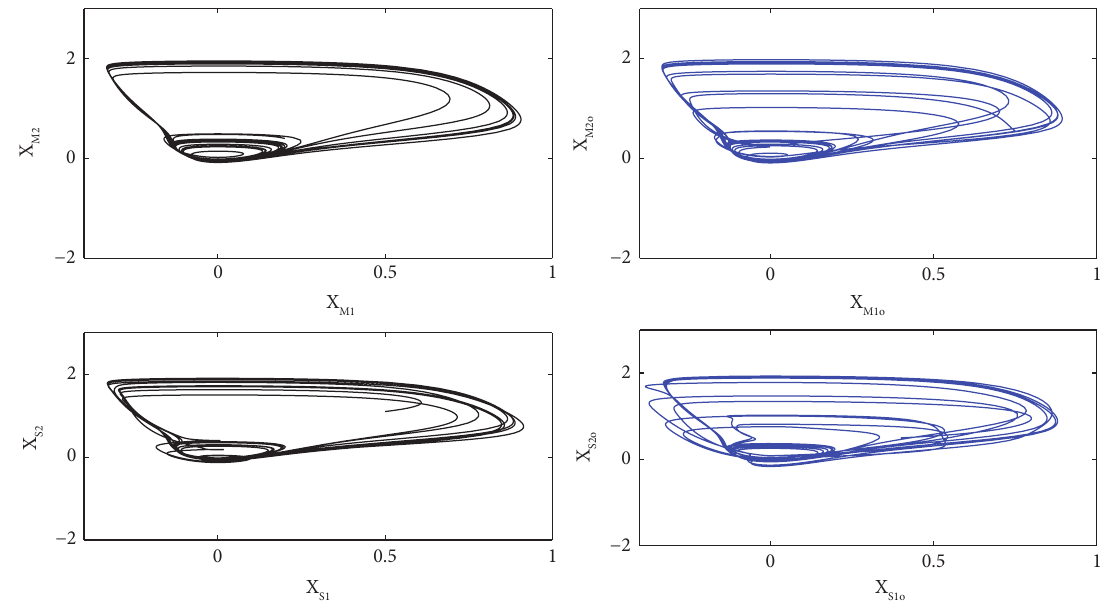
Figure 4: Phase portraits of master and slave systems of Theorem 1.